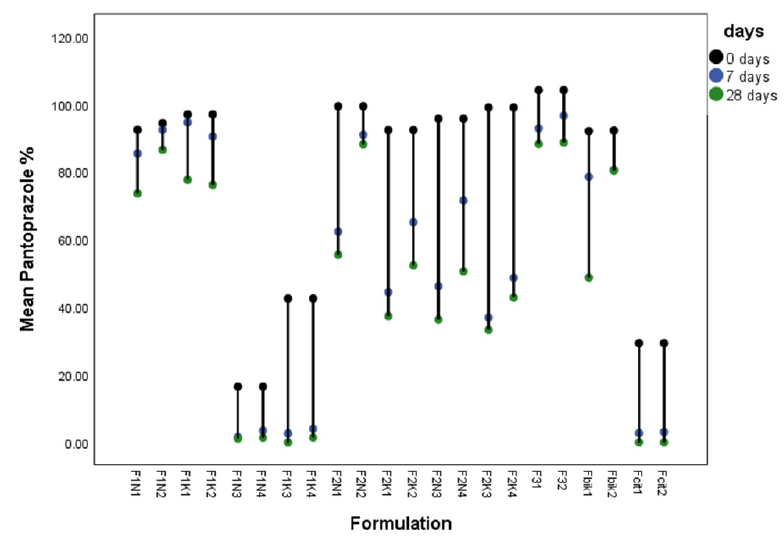
Figure 2. Content of pantoprazole (%) in 1 mL sample in all investigated formulations (with and without preservative and refrigerated and those kept at room temperature) with addition of citrate buffer (0.16 M) and bicarbonate solution (8.4%) at 0, 7 and 28 days. We also tested whether official syrup base could be safely kept for 28 days without preservative. The results of microbiological stability testing of syrups indicated that all formulations complied with pharmacopeial specifications for liquid non-sterile products. The F2K2 formulation had slightly increased TAMC values, though it contained preserva- tive, probably due to its crystallization in refrigerated conditions that could be seen during visual inspection (Table